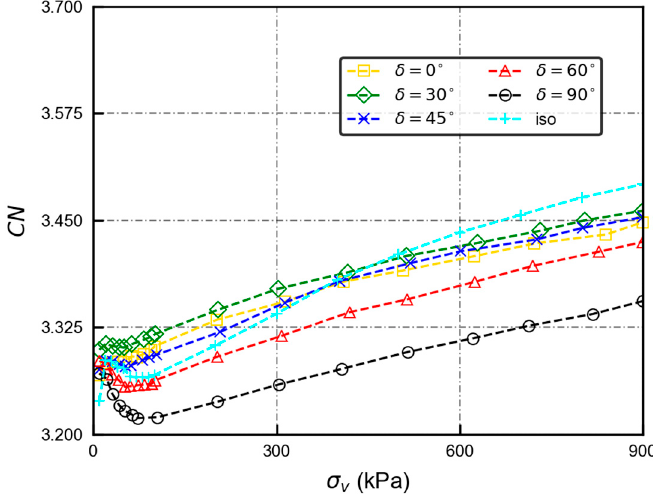
Figure 9. Coordination number CN versus vertical stress σ v along K 0 -loading path for the different initial anisotropy samples.